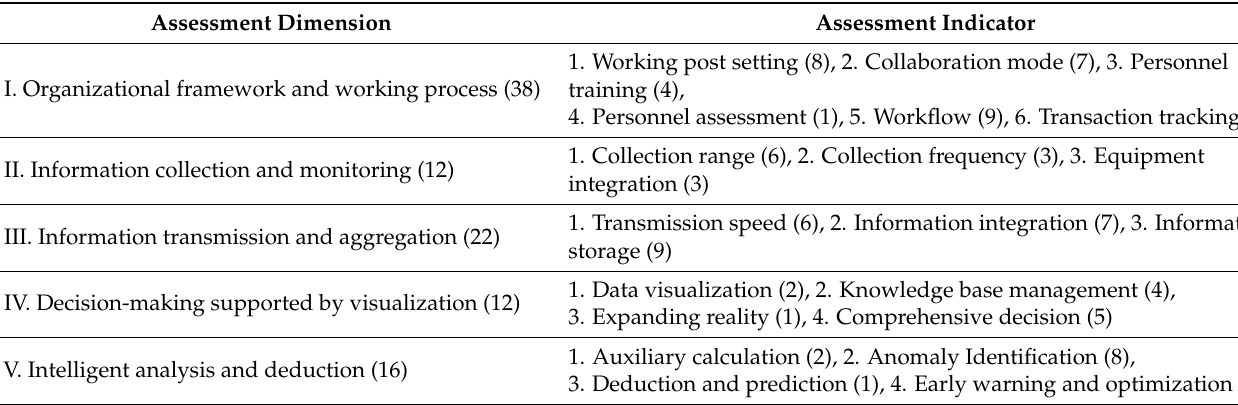
Table 7. Weights of dimensions and